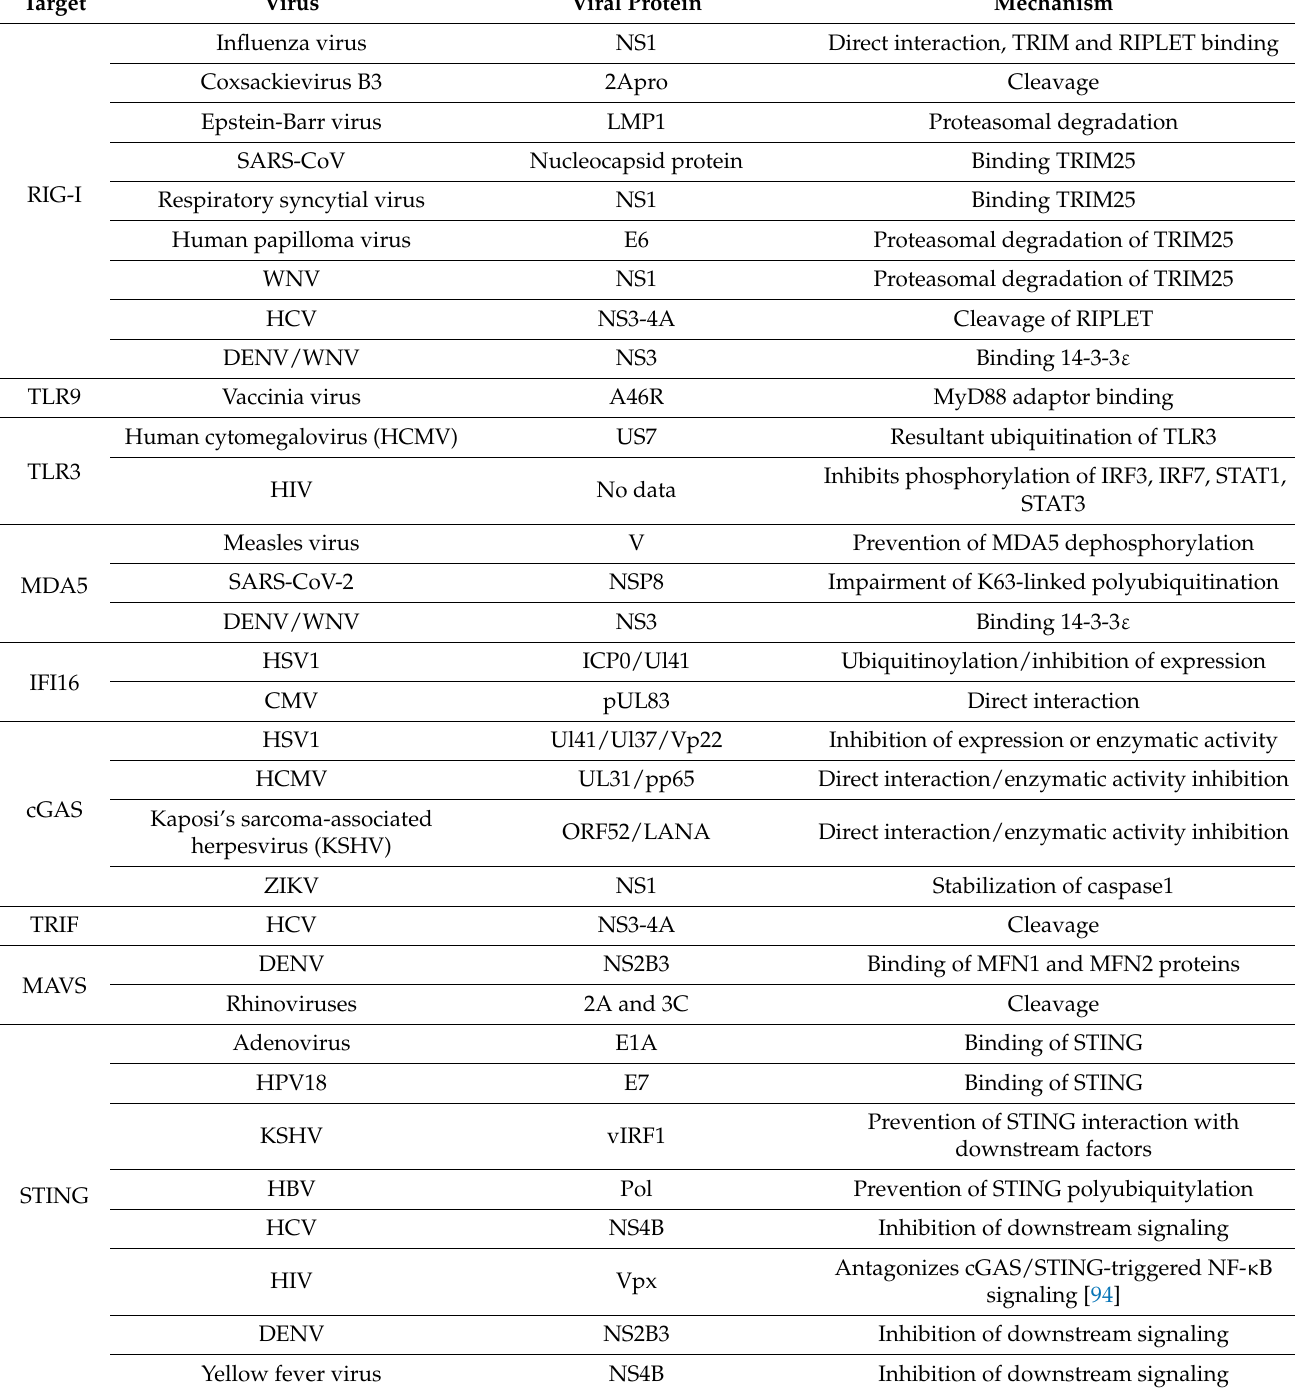
Table 1. Host factors targeted by viruses and mechanisms of immune